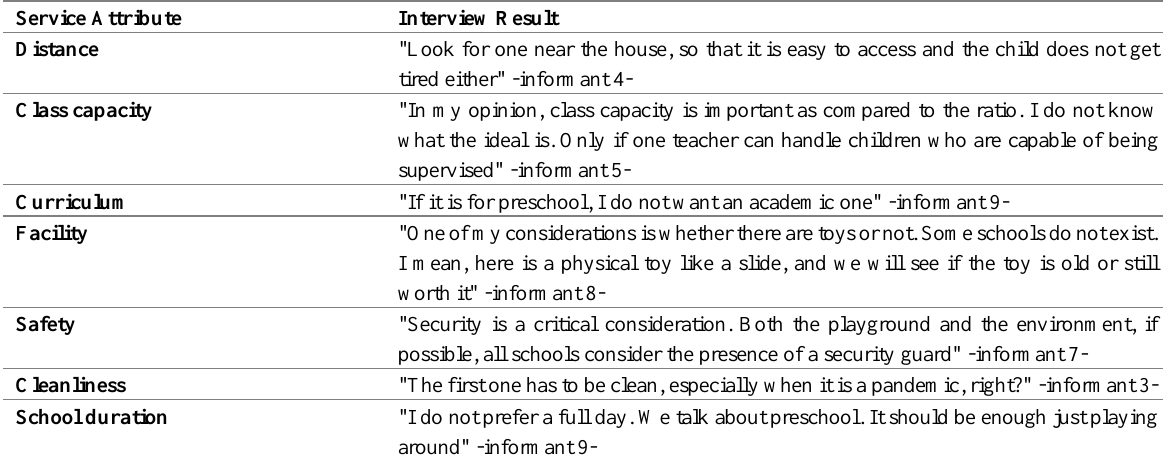
Table 1: The Summary Result of Interview with Millennial